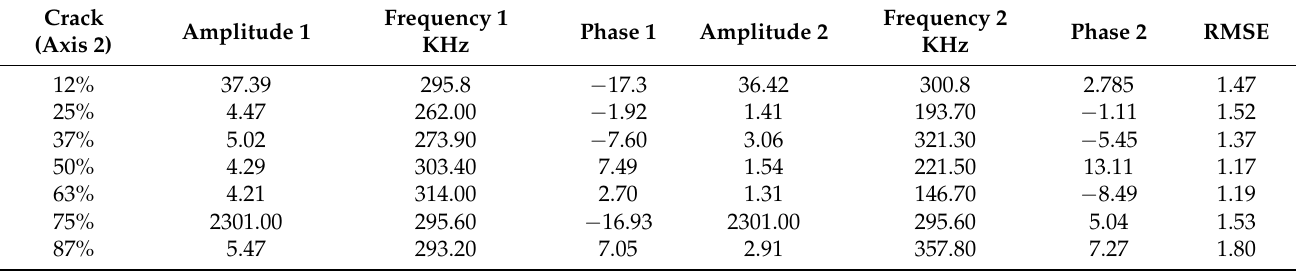
Figure 9. Comparison of the actual response and optimized mathematical model for the pipe with multiple damage locations indicated via percentage of offset between exciter and sensor locations along axis 1. Table 4. Optimized parameters and error terms for the numerical model for the cracks along axis